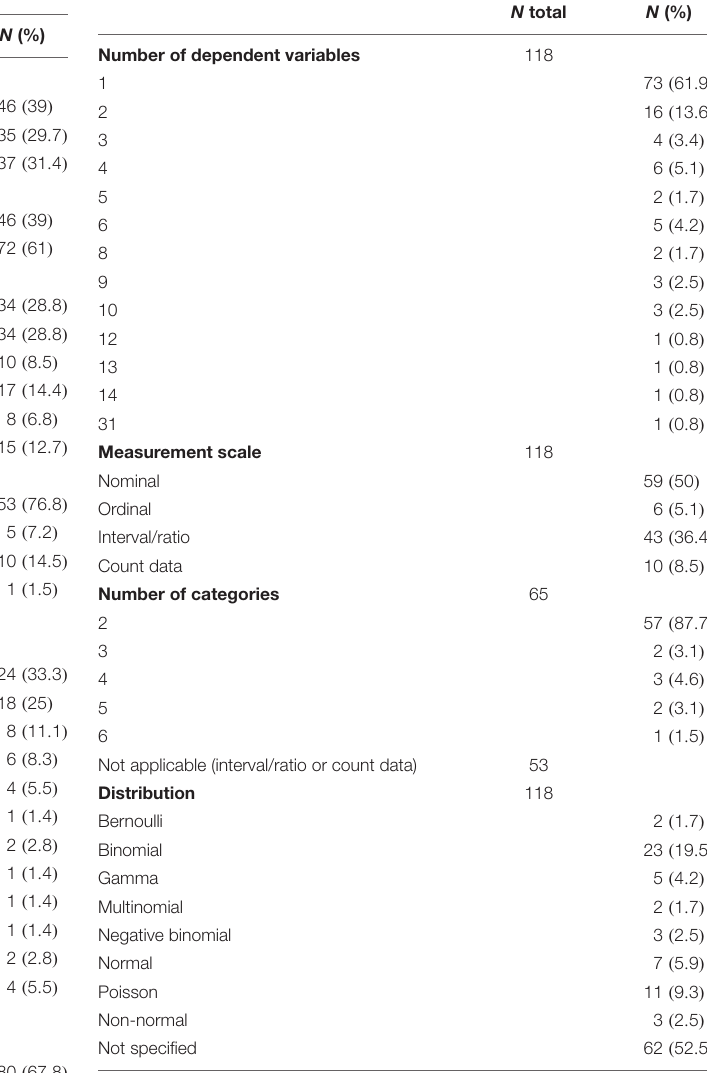
TABLE 1 | Characteristics of the design, sample, groups, and missing data in the 118 GLMM analyses.